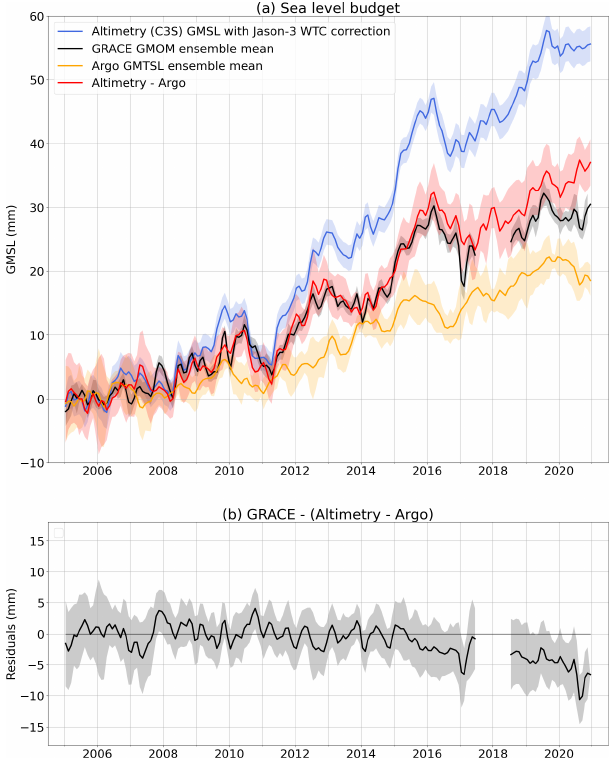
Figure 6. Ocean mass budget. (a) Budget with GRACE/GRACE- FO-based global mean ocean mass (GMOM) variations and the sum of its contributions from Greenland (GIS), Antarctica (AIS), land glaciers (GICs), terrestrial water storage (TWS) and atmospheric water vapour (AWV) variations. TWS variations are split into the climate-driven component from ISBA-CTRIP and the human- induced contribution trend estimated from WGHM (Cáceres et al., 2020). (b) Budget residuals. Linear trends of all components over different periods of time are provided in Table S1.